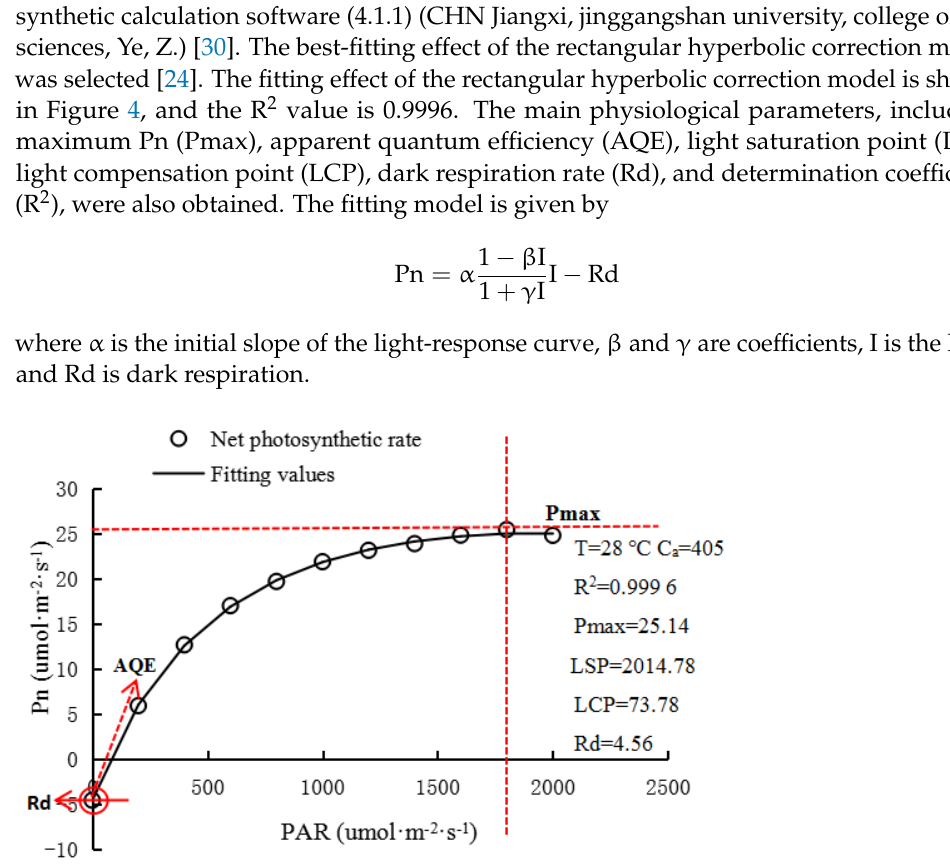
Figure 4. The rectangular hyperbolic correction model fits the light-response curve. (T: leaf temperature; Ca: reference chamber CO 2 concentration; R 2 : coefficient of determination; Pmax: the maximum net photosynthetic rate; LSP: light saturation point; LCP: light compensation point; Rd: dark respiration rate; AQE: apparent quantum efficiency).